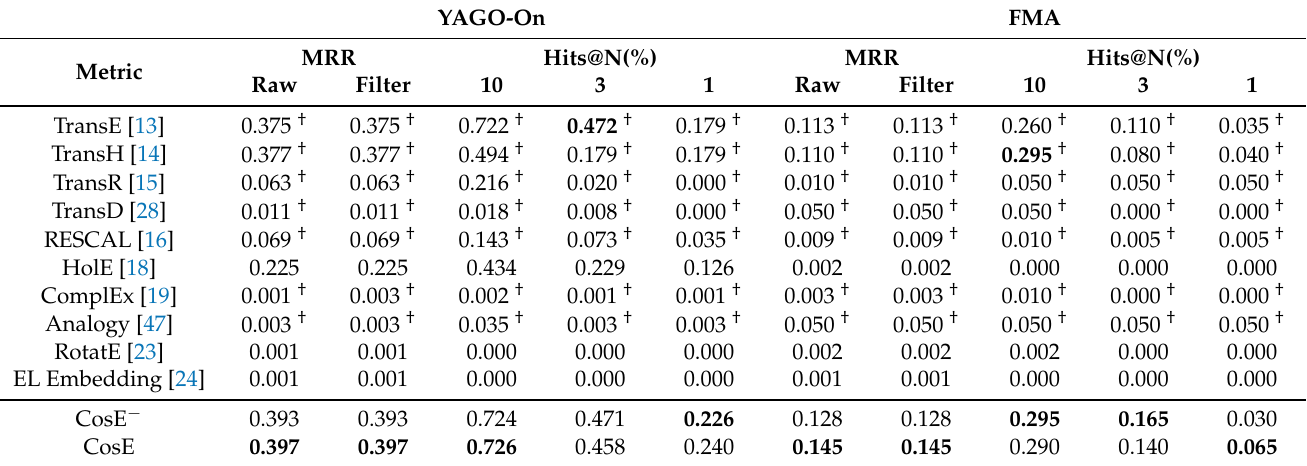
Table 4. The results of YAGO-On and FMA on link prediction about subclassOf axioms. YAGO-On FMA